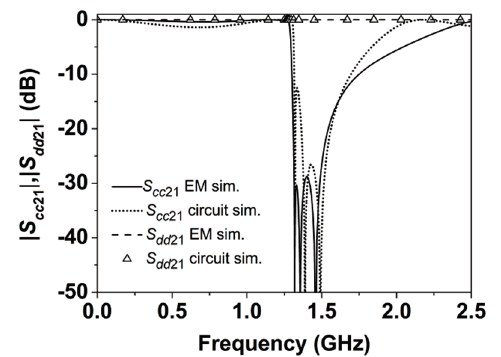
Figure 8. Simulated common-mode and differential-mode insertion loss | S cc 21 | and | S dd 21 | for the order-three structure that results by cascading three-unit cells like the one shown in Figure 7. Inter-resonator distance is 0.15 mm. From [36]; reprinted with permission from IEEE